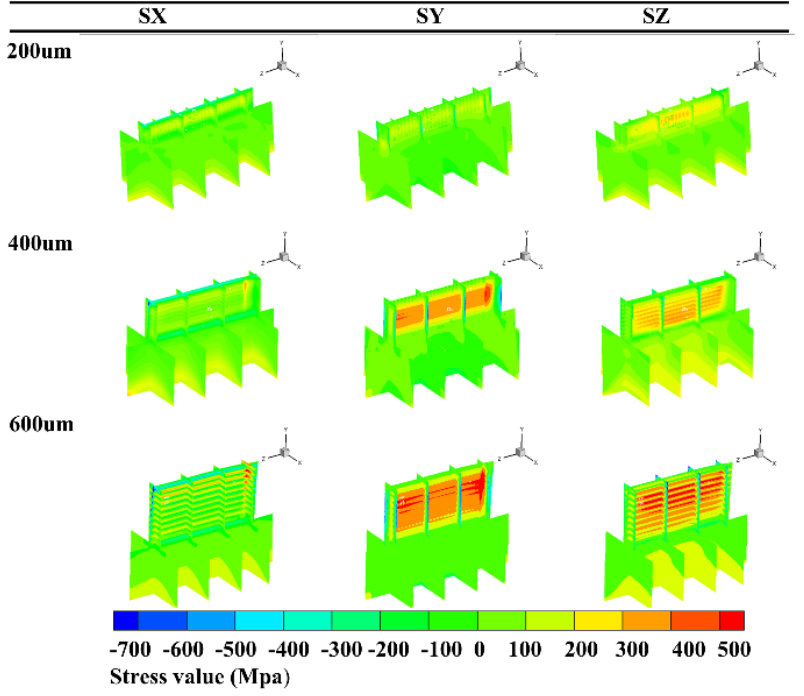
Figure 9. The stress distributions under different layer thicknesses when the laser power is 600 W